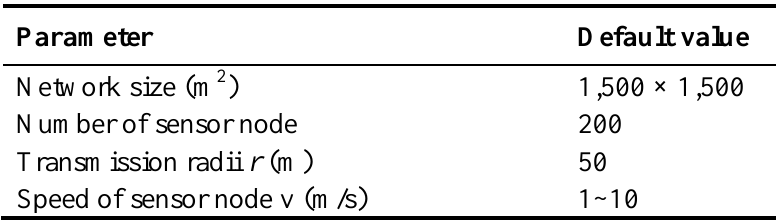
Table 1. Simulation